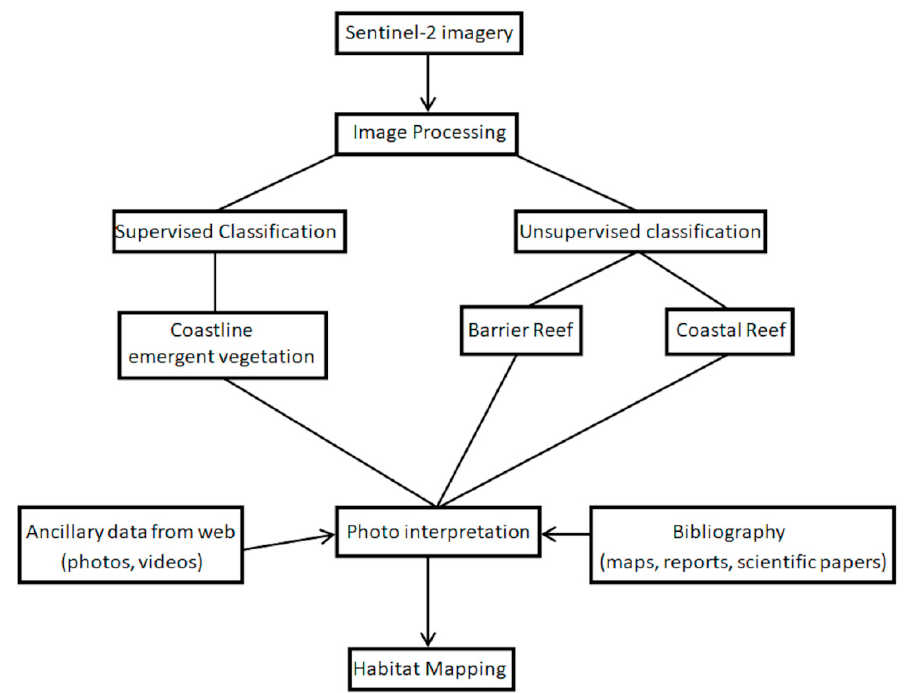
Figure 3. Workflow diagram illustrating the steps followed for the habitat mapping of Palau.